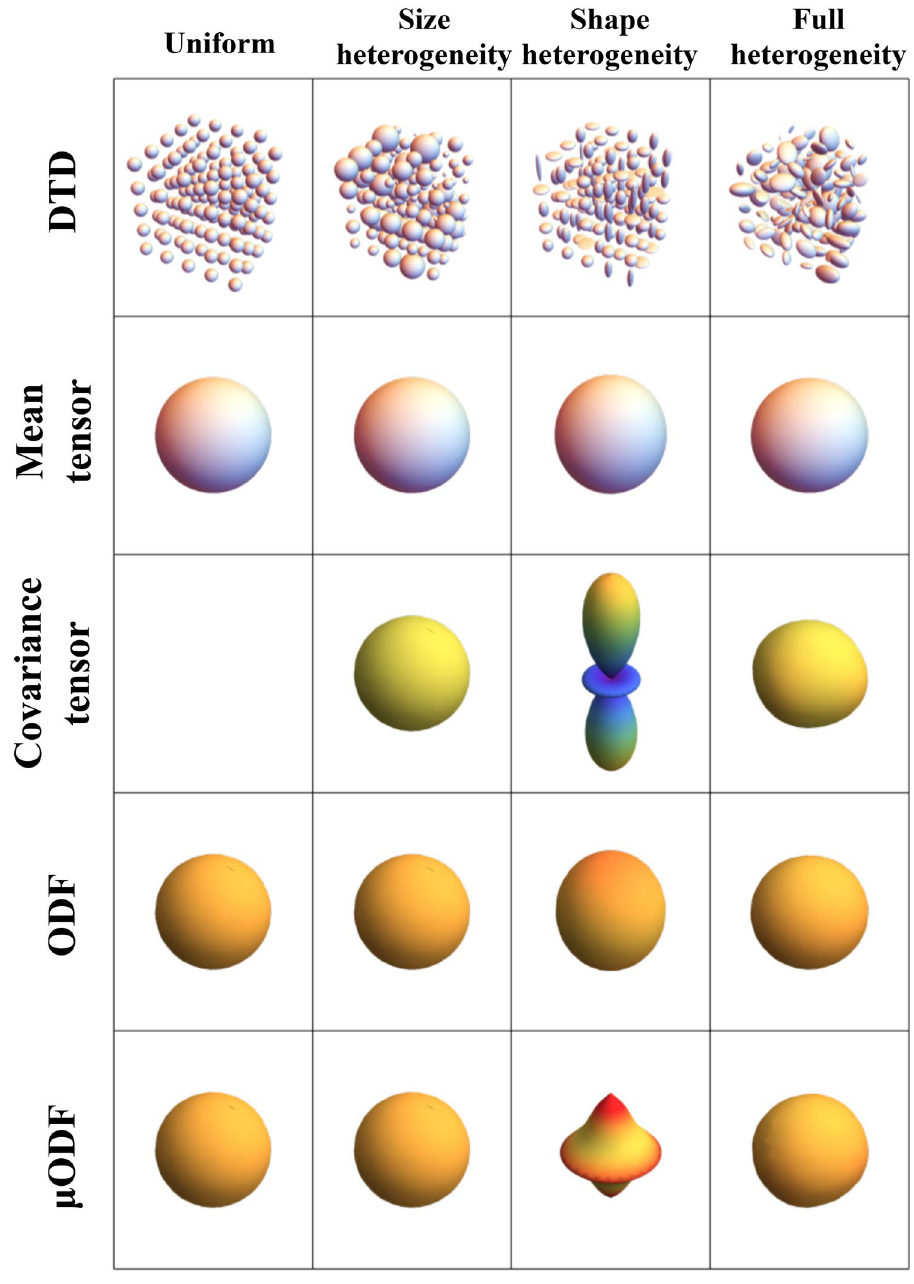
Figure 7. Glyphs describing macroscopically isotropic and microscopically heterogeneous DTDs generated from CNTVD. (First row) DTDs describing uniform, size, shape and orientation/size/shape heterogeneous voxels respectively. (Second row) Second order mean tensor displayed as an isosurface for each of the DTDs. (Third row) Fourth order covariance tensor projected in 3D for each of the DTDs. (Fourth row) Macro ODF obtained from the mean diffusion tensor. (Fifth row) Micro ODF obtained by averaging the ODFs of individual micro diffusion tensors in the voxel. The above graphics was generated using the Mathematica software 67